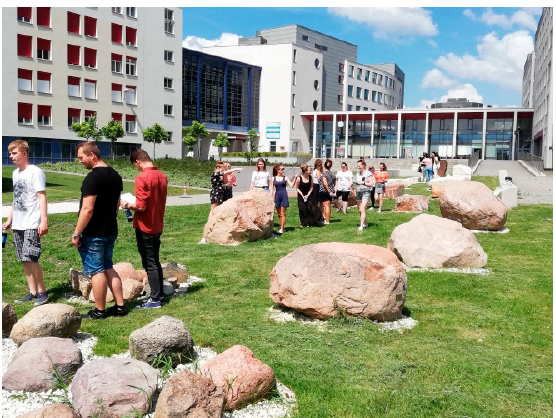
Figure 13. The Rock Garden hosts didactic classes for students of Jan Kochanowski University in Kielce.